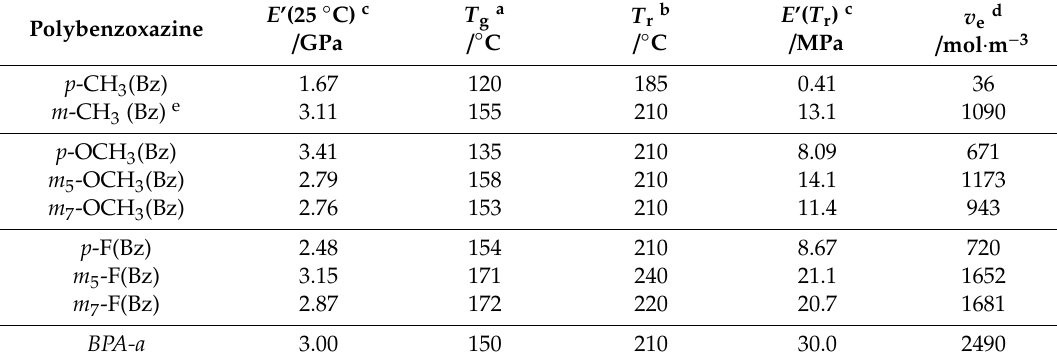
Table 3. Dynamic mechanical analysis (DMA) results and calculated crosslink densities.